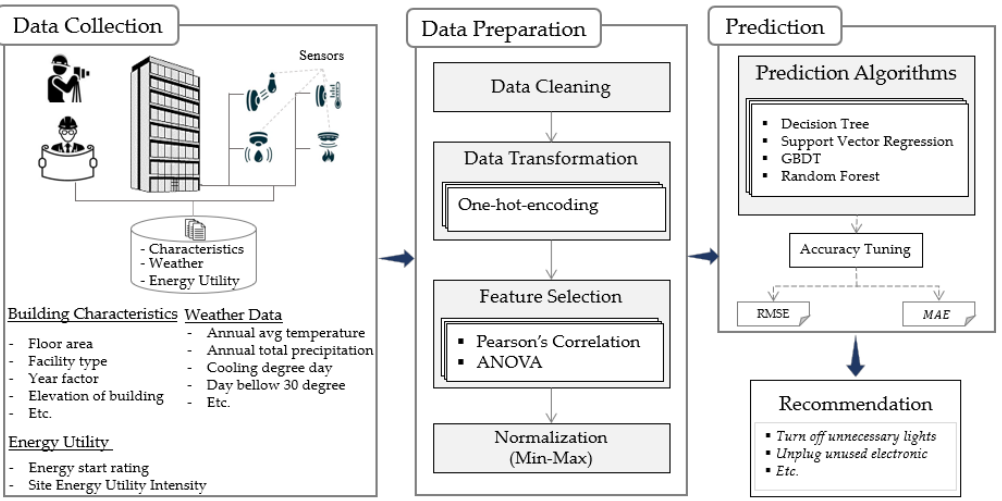
Figure 1. Conceptual representation of the proposed procedure.